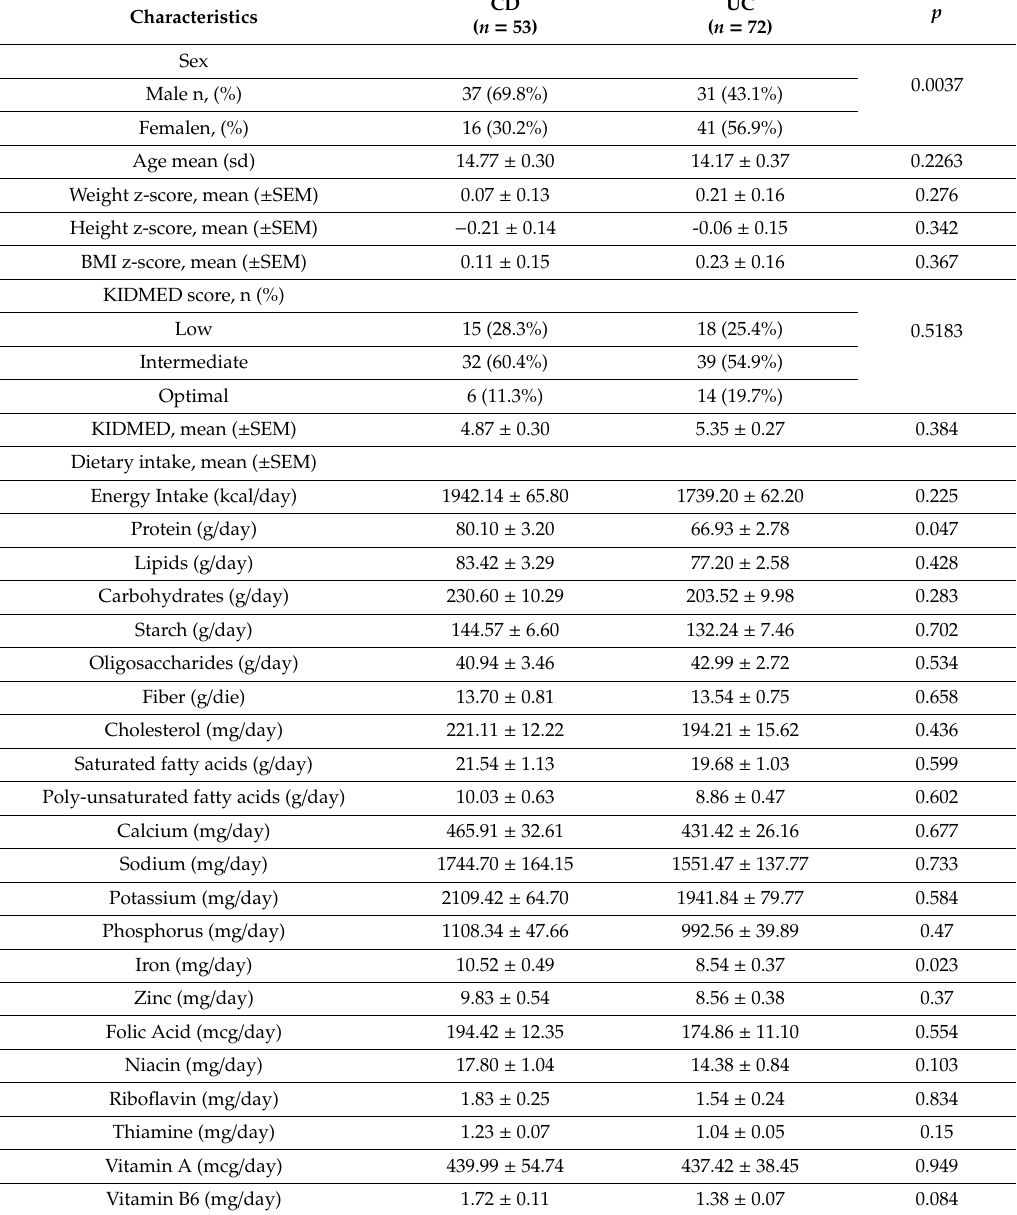
Table 3. Comparison between Crohn’s disease and Ulcerative colitis patients regarding anthropometric parameters, KIDMED, macro and micronutrient